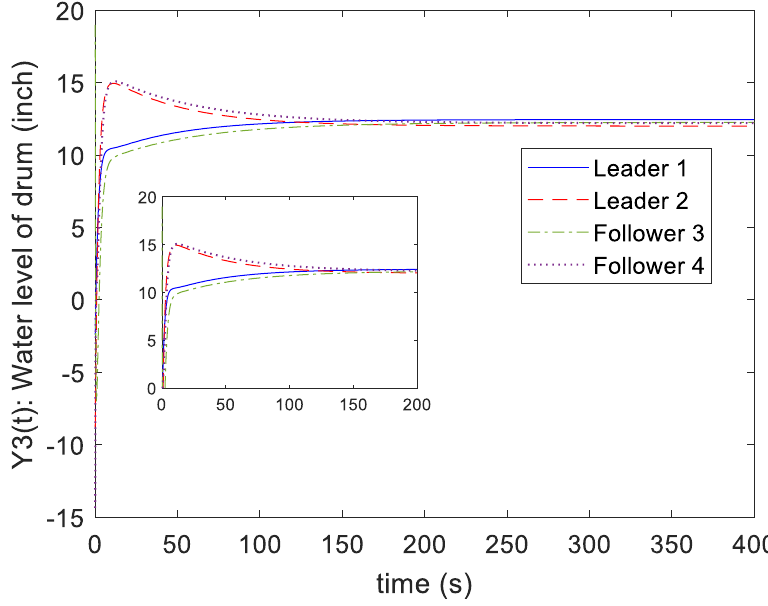
Figure 16. Responses of output Y 3 ( t ) with type-1 fuzzy control.